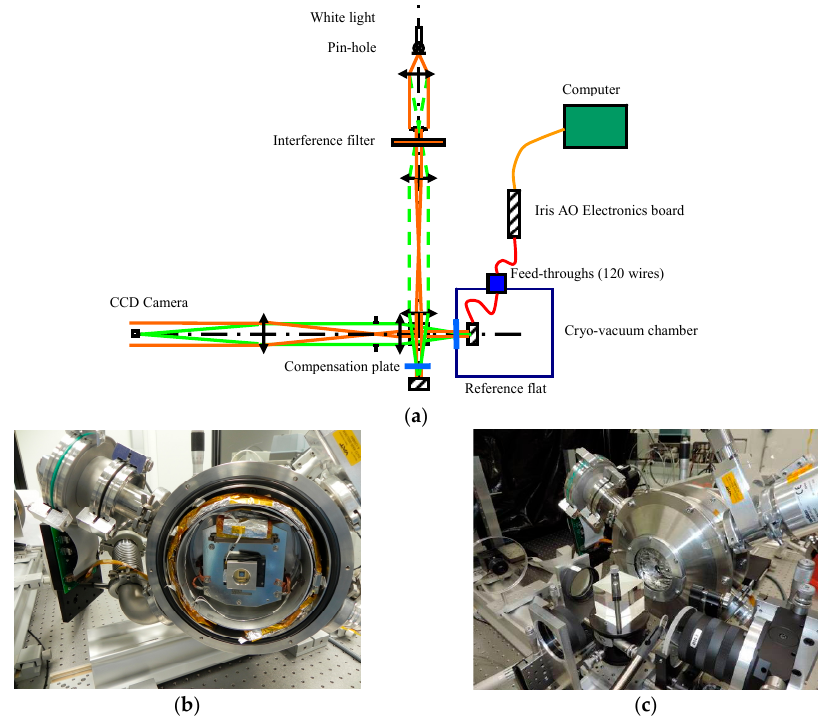
Figure 5. ( a ) Schematic description of our interferometric measurement set-up with the cryo-vacuum chamber; ( b ) PTT111 device mounted in the cryogenic chamber for characterization in a space environment; ( c ) Front window is closed and the cryogenic chamber is installed in front of our interferometric setup. The segmented deformable mirror could be successfully actuated before, during, and after cryogenic cooling at 160 K.